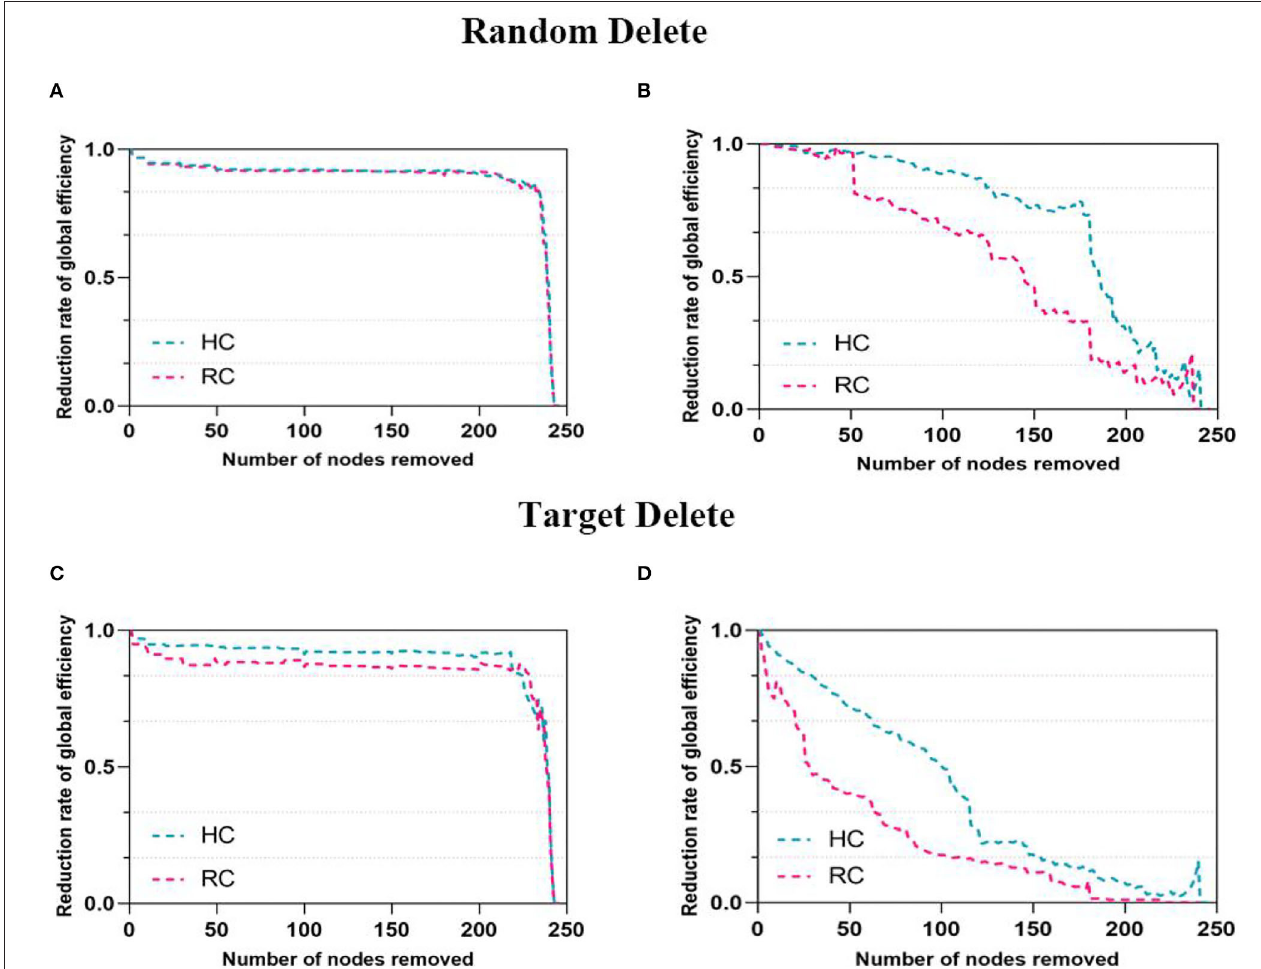
FIGURE 4 | Network resilience under random and target analysis. The alterations of global efficiency under removing node at random (first panel) and targeted pattern (second panel). The blue line corresponded to the performance of HC, pink line for RC. The (A,C) were for FN and the (B,D) were for